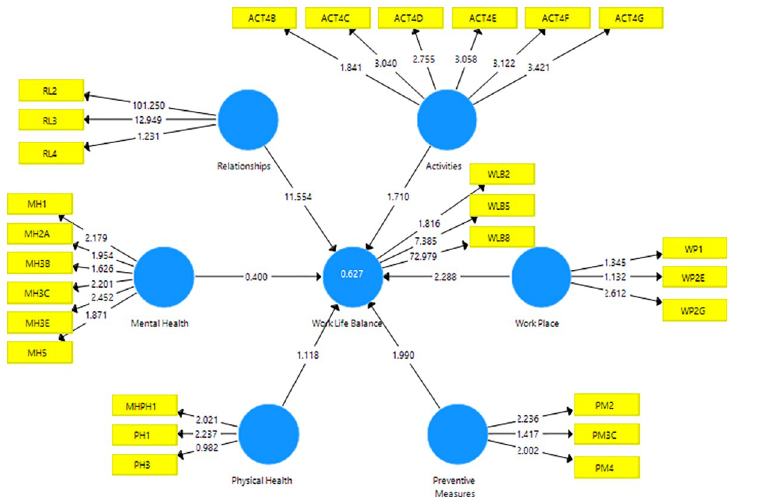
Fig 2. t-statistics for the inner and outer